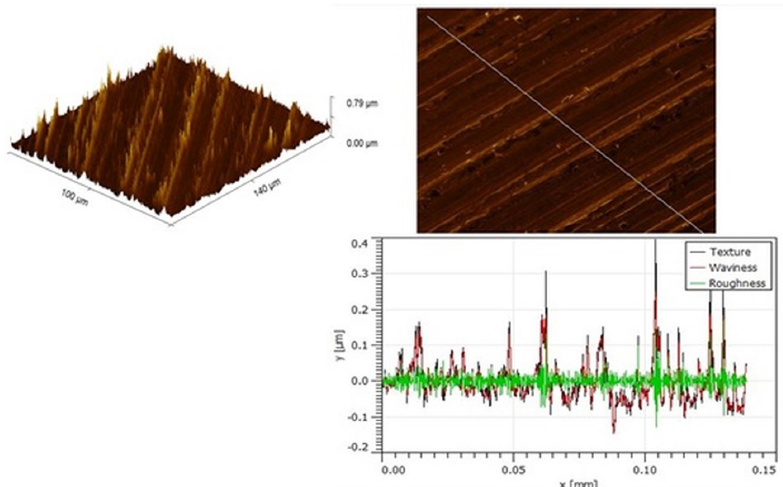
Figure 8. AFM images for the specimen 3 (15N of Load, 400 rpm of disc speed, 3 m/sec of velocity and wear rate of 0.01355 mm 3